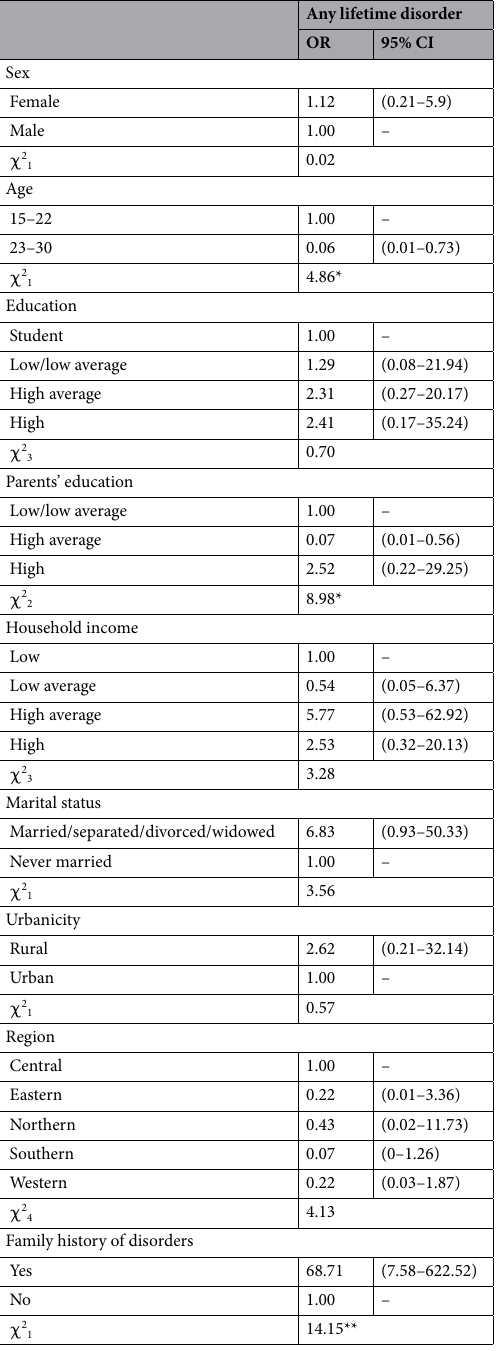
Table 5. Predictors of treatment among Saudi youth with DSM IV/CIDI lifetime mental disorders. Part II sample was used; *p < 0.05; **p < 0.001. Any disorder (n = 101), out of the respondents who received any treatment. Low and low average categories were combined for education and parents’ education due to low frequencies (n ≤ 10); married/separated/widowed/divorced were combined for marital status due to low frequencies for the subcategory separated/divorced/widowed (n <